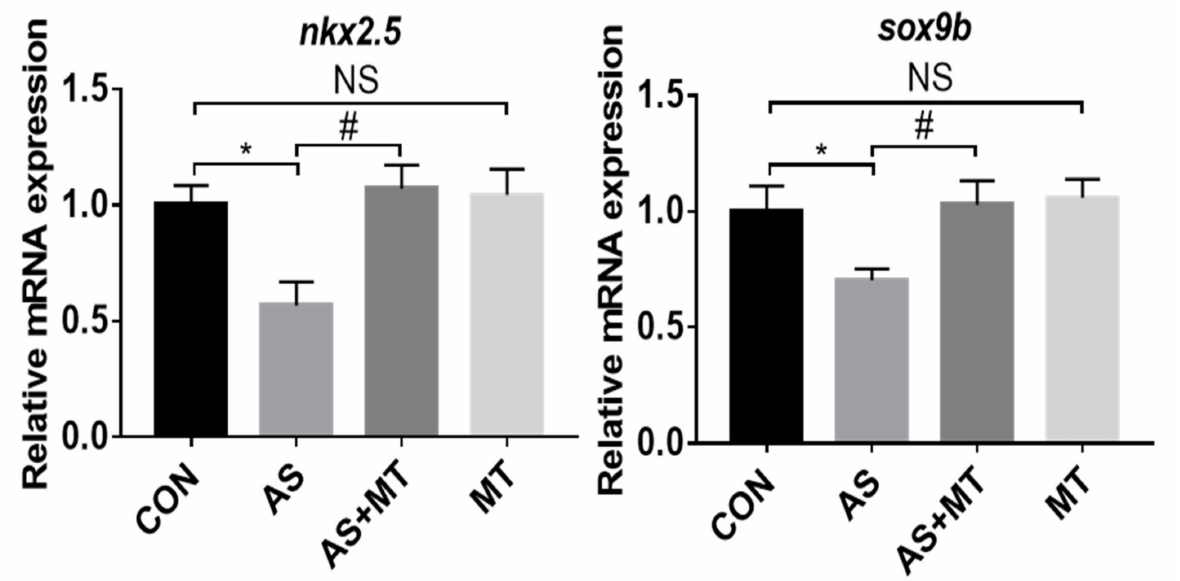
Figure 4. The effects of melatonin on the NaAsO 2 -induced relative mRNA expression levels of the genes essential for heart development in zebrafish embryos at 72 hpf. CON: system water as the vehicle control; AS: NaAsO 2 at 1.0 mM; MT − 9 : Melatonin at 10 − 9 M. * p < 0.05, compared to CON; # p < 0.05, compared to MT; NS, compared to